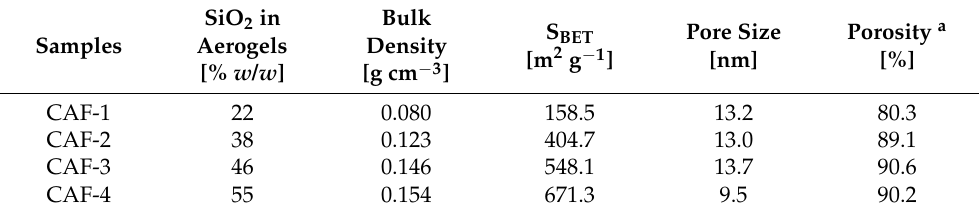
Table 1. Physical properties of CAFs.